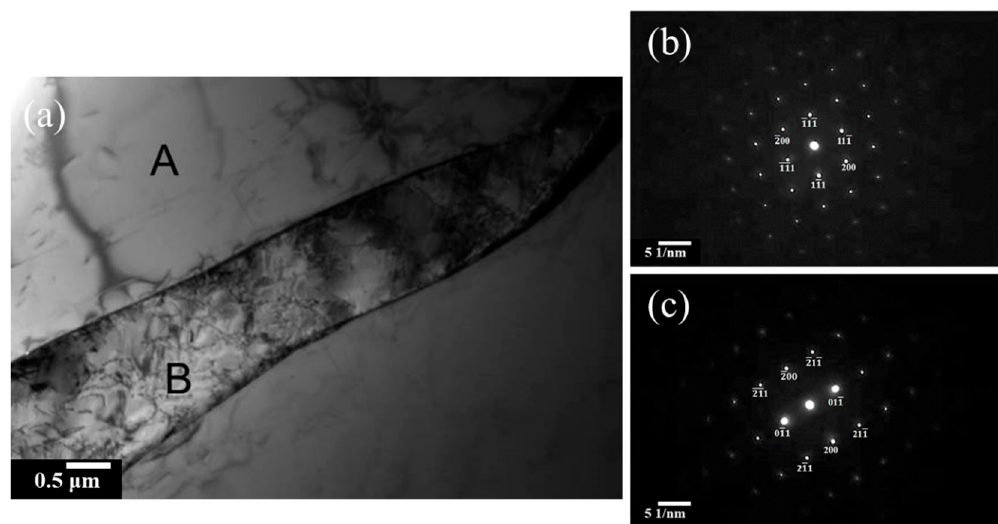
Figure 2. TEM micrographs of 2205 after solution treatment: ( a ) bright field (BF) image revealing the γ (region A) and α (region B) duplex phases; ( b ) selected area diffraction pattern (SADP) of the matrix marked as A in ( a ) where the foil normal is [011]; and ( c ) SADP of the matrix marked as B in ( a ) where the foil normal is [011].